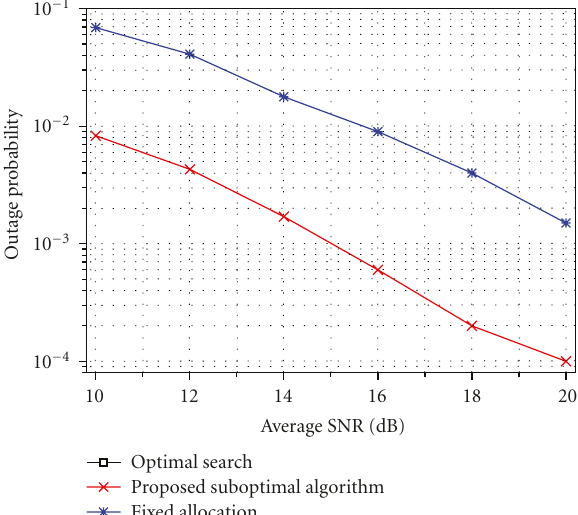
Figure 8: Throughput of nonreal-time (NRT) service